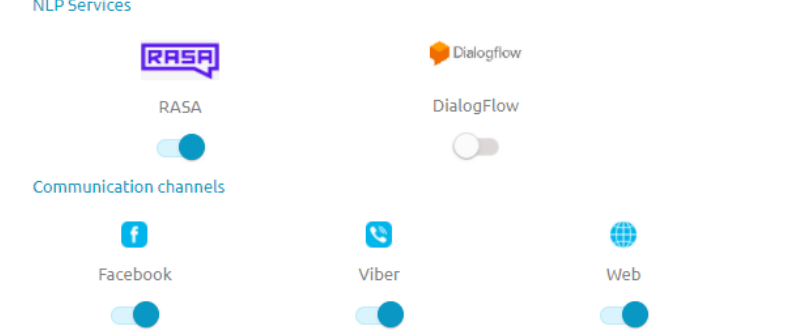
Figure 10. Bot Designer.